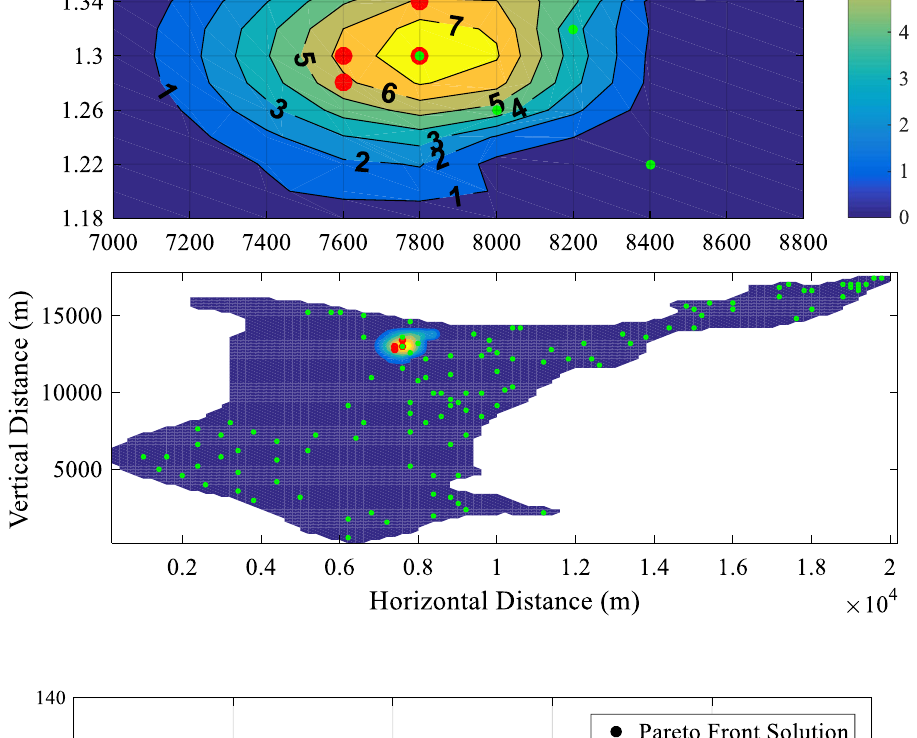
Fig. 15 Pareto fronts in NSGA- II algorithm (Real